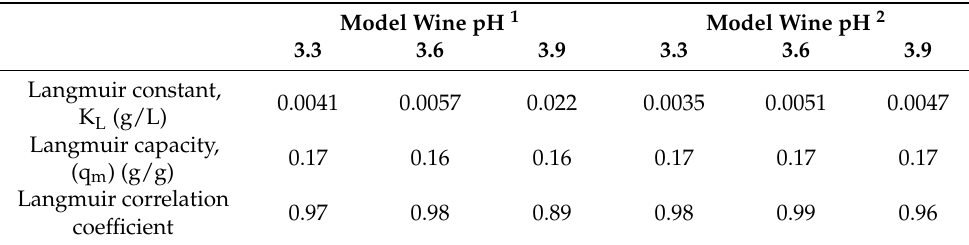
Table 2. Effect of pH on protein adsorption and removal from model wine solutions by the ion- exchange resin Macro-Prep ®